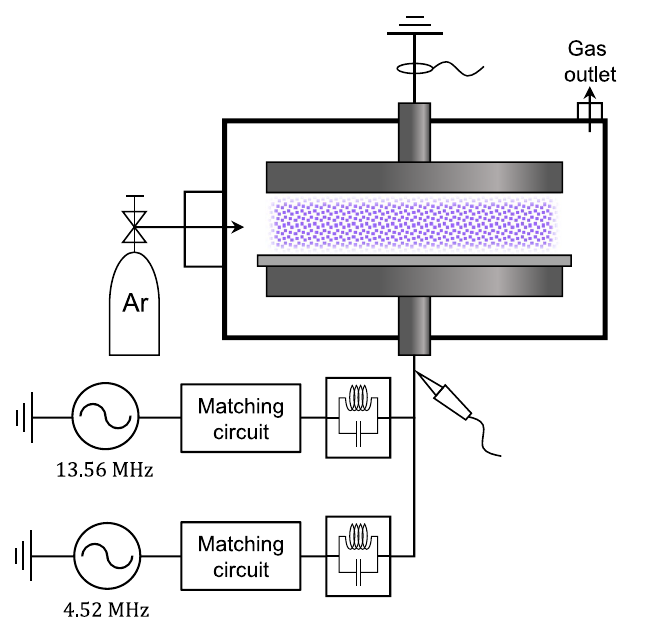
Figure 5. Information regarding the experimental apparatus. Schematic of the plasma apparatus for generating argon radio-frequency capacitive discharge at atmospheric pressure and the relevant experimental